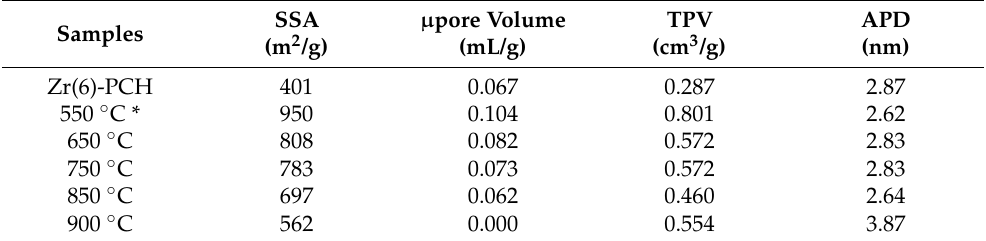
Table 3. Microtextural properties of Zr(6)-PCH precursor calcined at different temperatures.